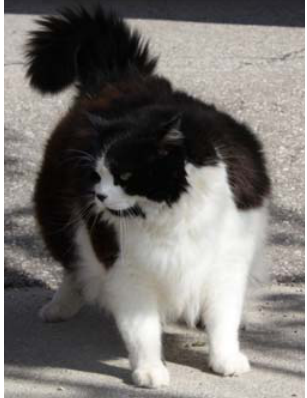
Figure 2. Obesity predisposes cats to hepatic lipidosis.